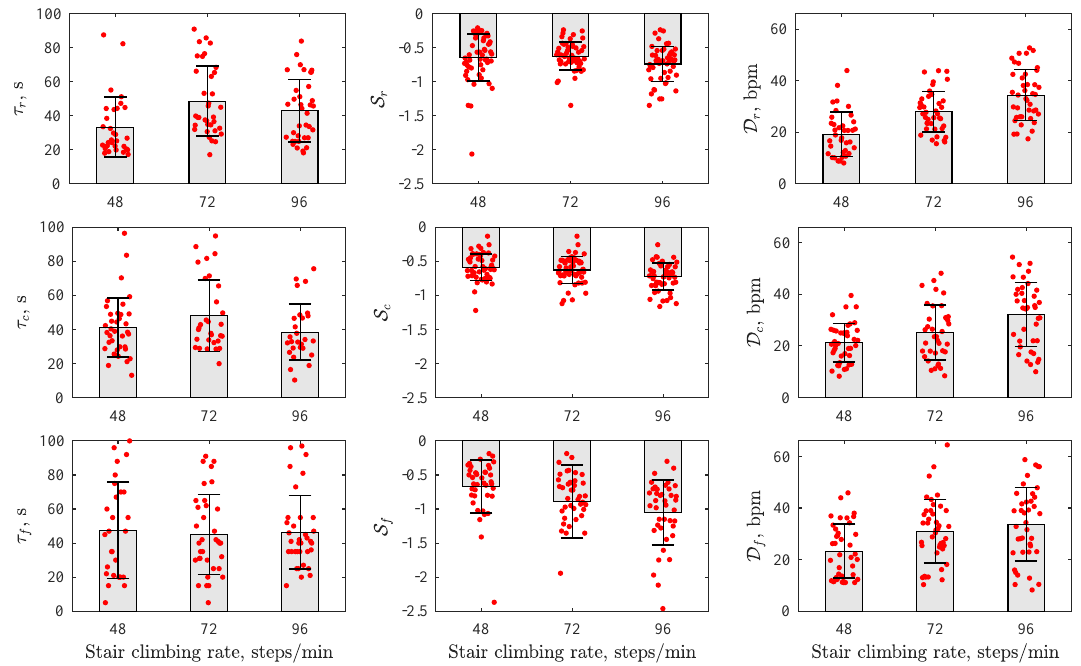
Figure 7. HRR parameters estimated at different stair climbing